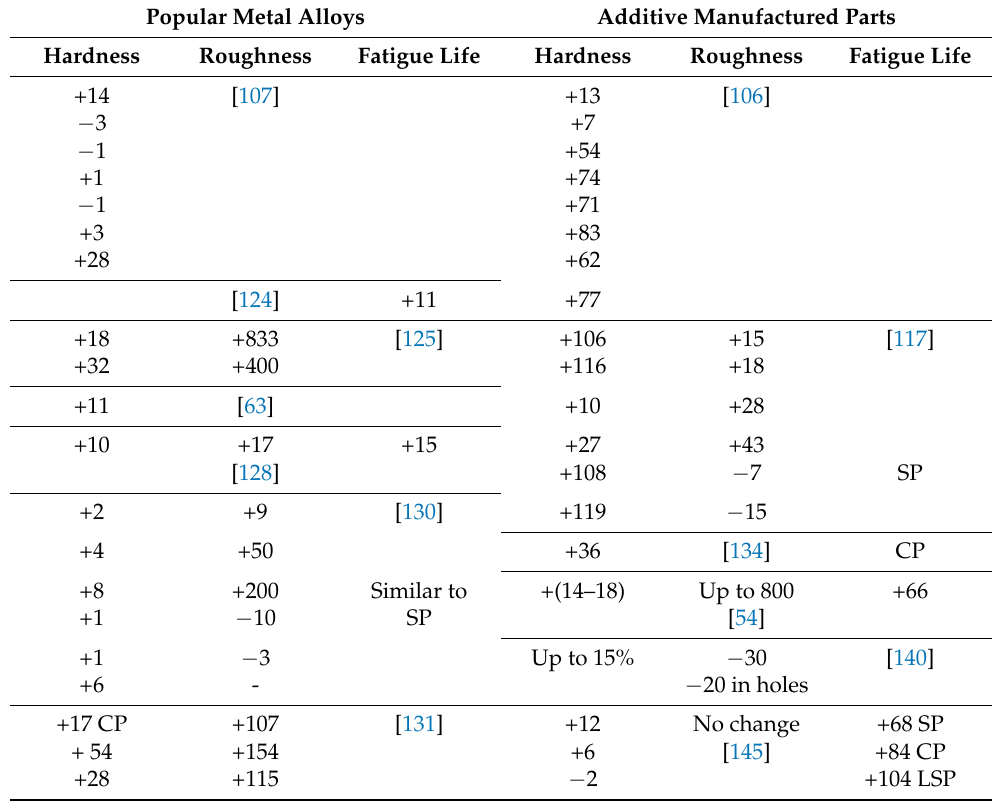
Table 4. Comparison of changes in hardness, roughness (Ra parameter) and fatigue life reported for popularand additive manufactured metallic materials. The values in the table are the percentage increase or decrease [%] due to peening process. Popular Metal Alloys Additive Manufactured Parts Hardness Roughness Fatigue Life Hardness Roughness Fatigue